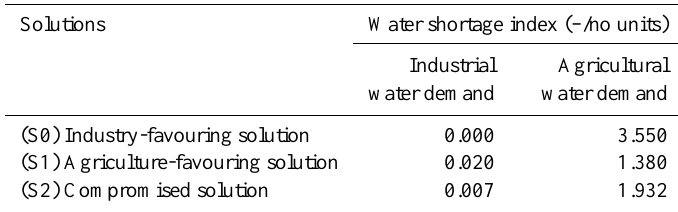
Table 3. Comparisons of water shortage indices among different solutions.